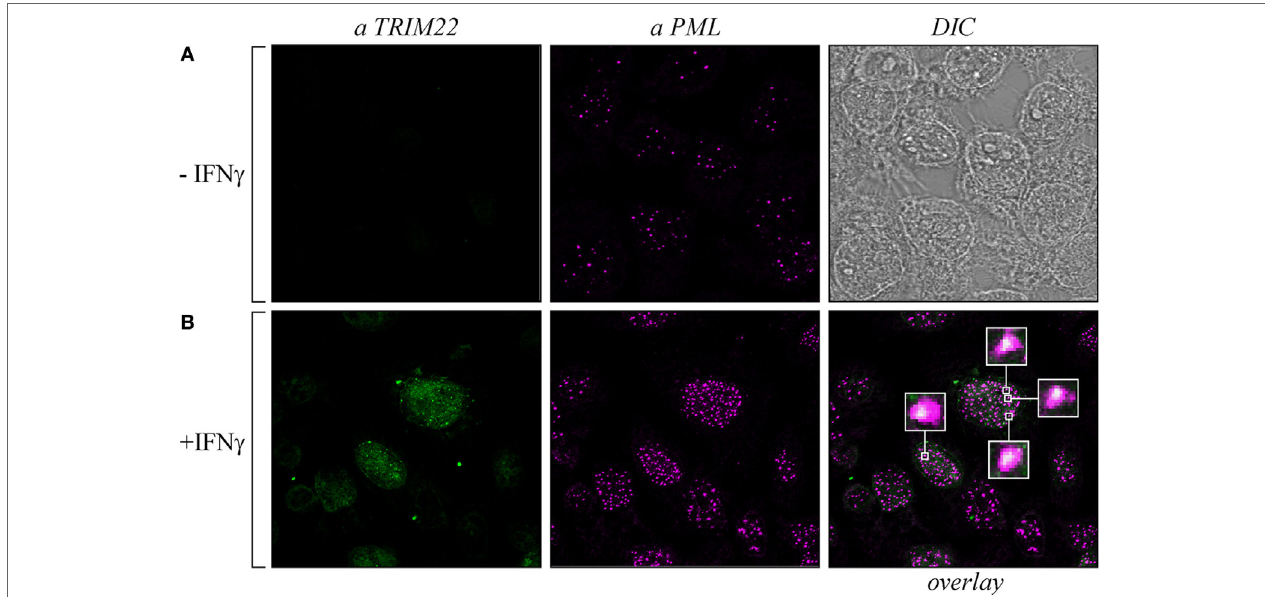
FigUre 3 | Promyelocytic leukemia (PMl) colocalized with endogenous tripartite motif-containing protein 22 (TriM22) in hep-2 cells treated with iFn γ . Hep-2 cells were incubated with IFN- γ (150 U/ml) ( + IFN γ ) (B) or with vehicle ( − IFN γ ) (a) for 48 h and analyzed by immunofluorescence and confocal microscopy. TRIM22 was detected with anti-TRIM22 mouse monoclonal antibody followed by goat anti-mouse AlexaFluor 633-conjugated antibody. PML was detected with anti-PML rabbit polyclonal antibody followed by goat anti-rabbit AlexaFluor 546-conjugated antibody. Insets show enlarged views of the areas indicated by the white squares. DIC is the differential interference contrast